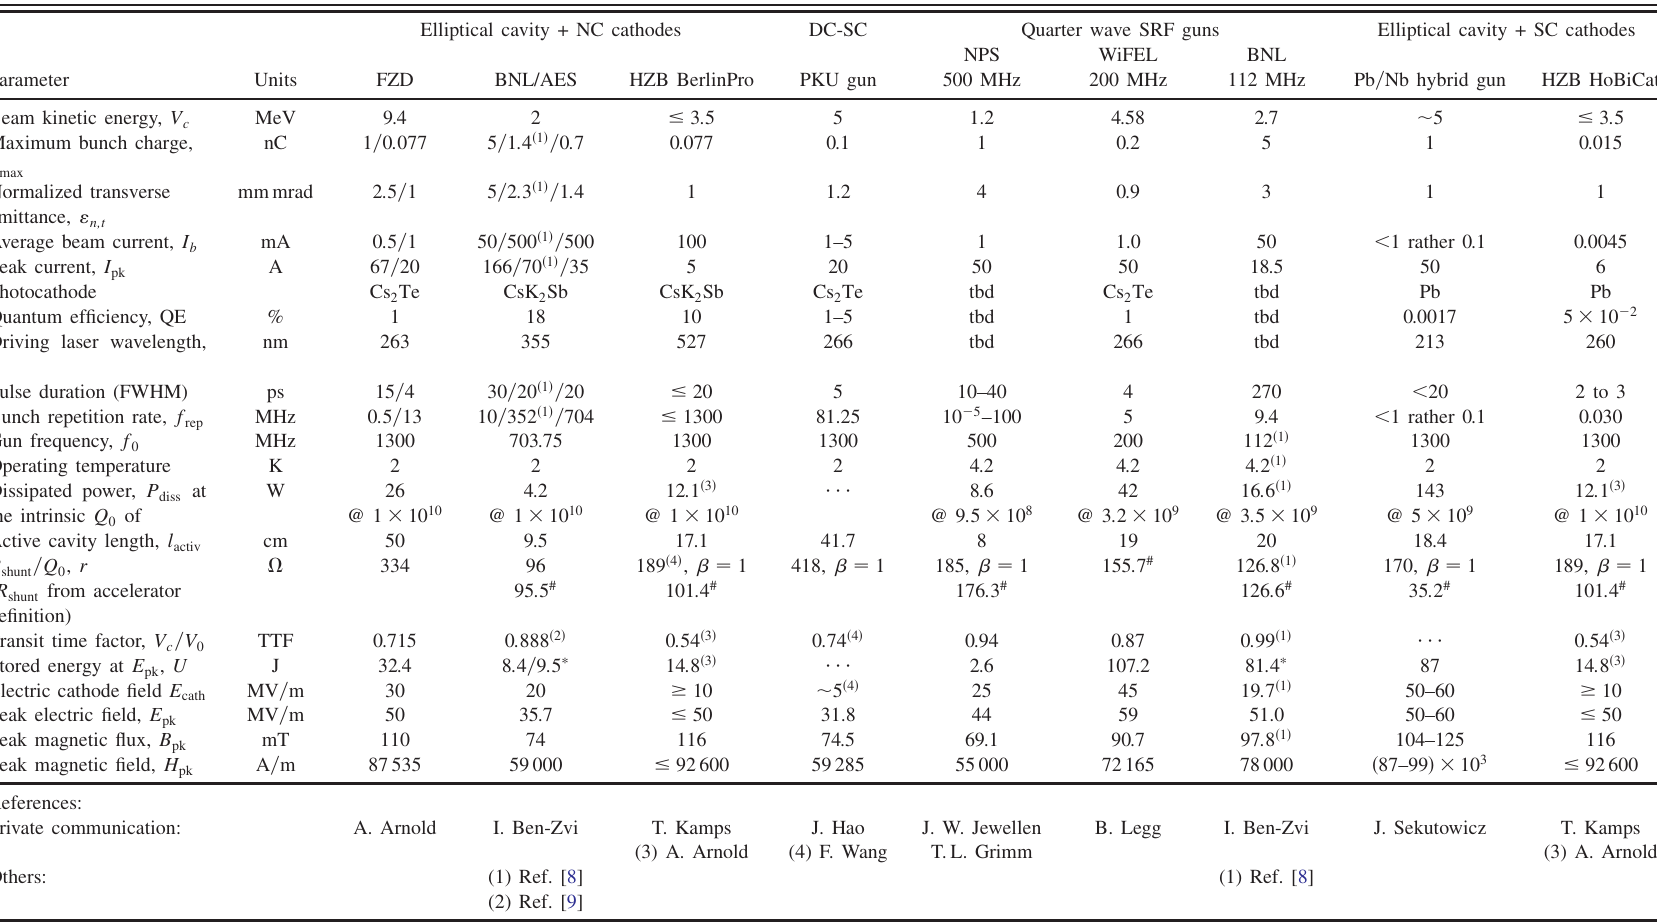
TABLE I. Comparison of all presently known SRF gun projects and whose expected parameters. Most of the information was provided by the expert named first in the last row. Values taken from other references are additionally marked by an index in the table. Values marked by # are calculated out of V C and U and those that are marked by * are calculated using P diss and Q 0 . Still open parameters are filled in with tbd (to be